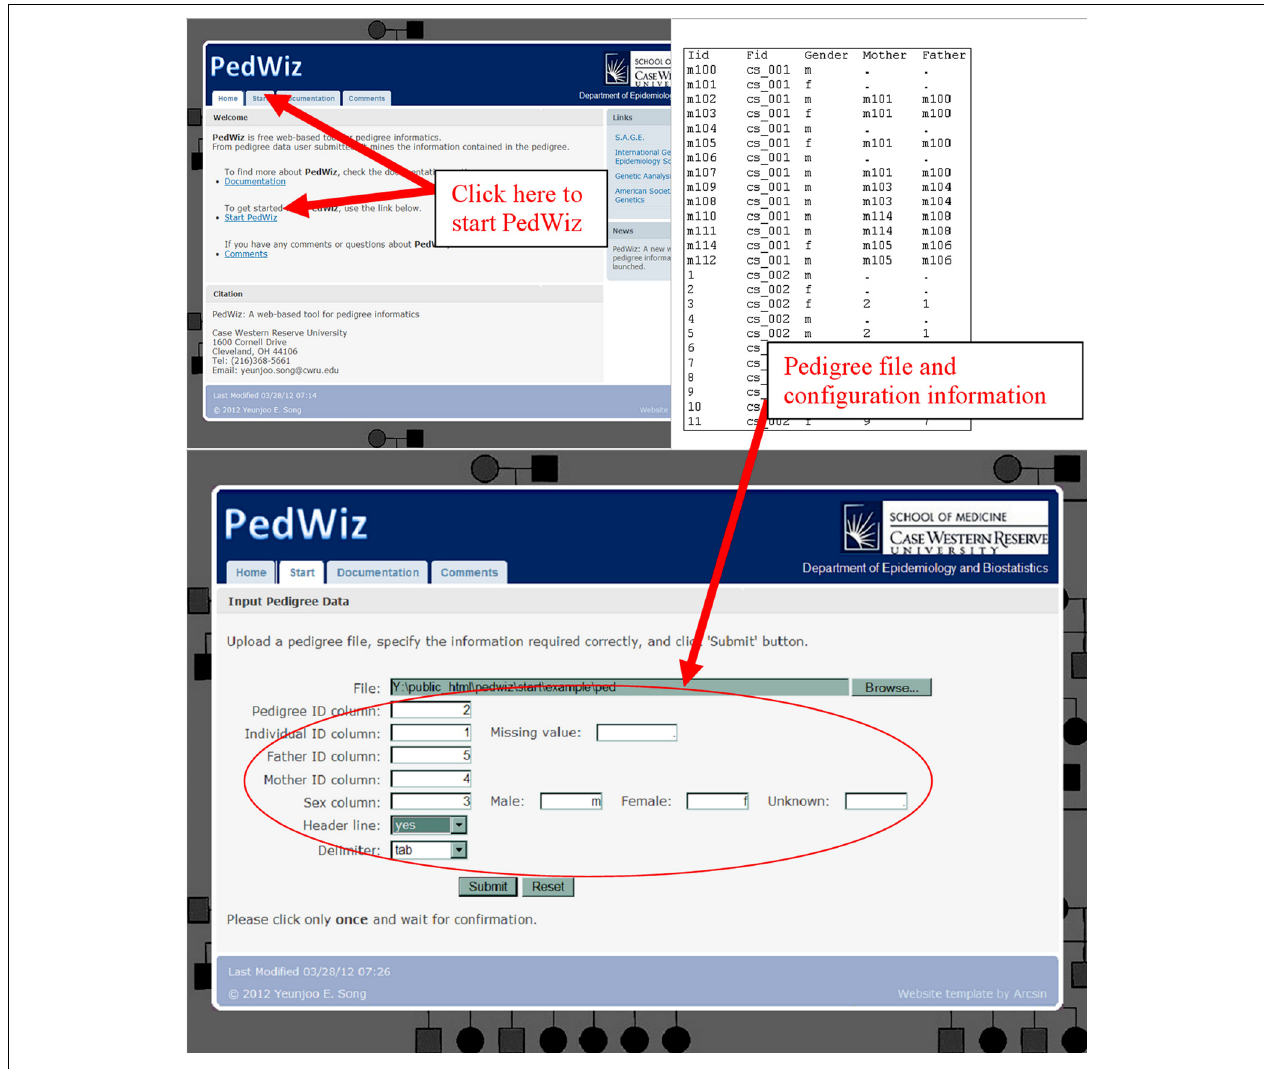
FIGURE 2 | Starting PedWiz .This figure illustrates the user interface to start